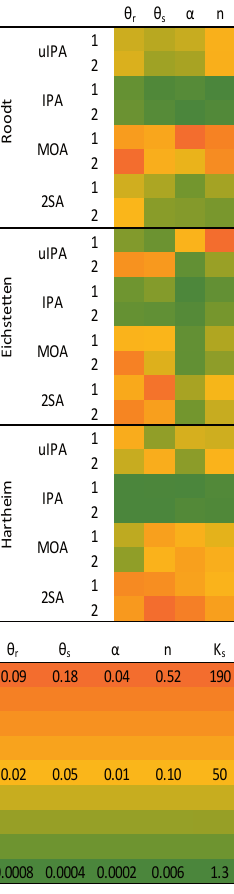
Figure 3. Parameter identifiability of each parameter calibrated at each site with the different inverse model approaches (uIPA, IPA, MOA, 2SA) for the upper (1) and lower (2) soil horizon. Colour indicates the parameter ranges between the 10th and the 90th per- centile of the of the parameter combinations of the set S best for each approach and study site. Green indicates a small range, yel- low medium and orange represents a high